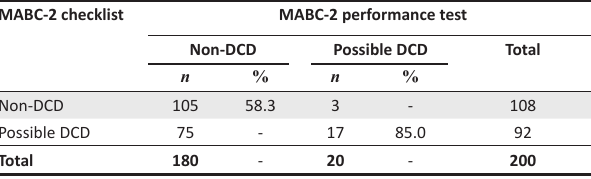
TABLE 5: Inter-rater agreement between the movement assessment battery for children - second edition performance test and the movement assessment battery for children - second edition checklist with the non-developmental coordination disorder group and possible developmental coordination disorder